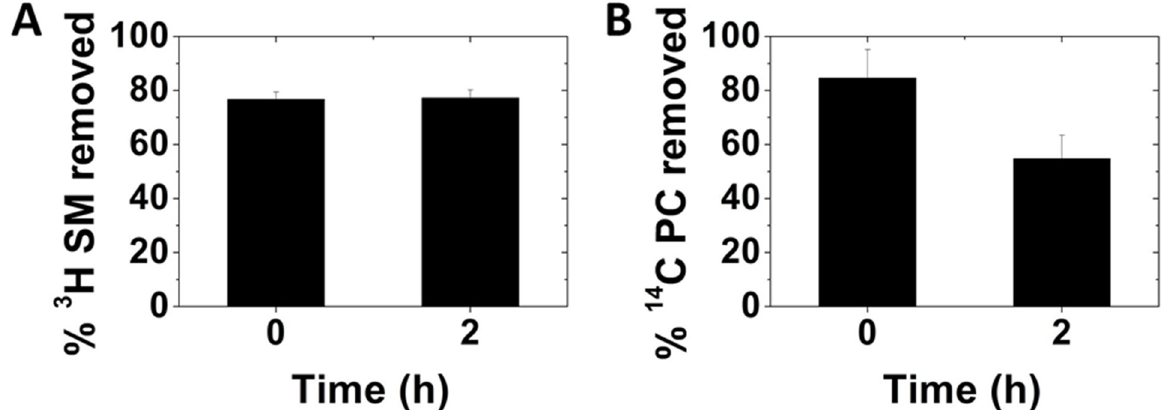
Fig 11. Analysis of back exchangeability of radiolabeled SM or POPC introduced into A549 cells by lipid exchange. (A) Back exchangeability of 3 H-SM immediately after exchange (0) or 2 h recovery after exchange with 1:1 bSM:POPC. (B) Back exchangeability of 14 C-DOPC immediately after exchange (0) or 2 h recovery after exchange with POPC. The p value for the significance of the difference at 0 and 2 h is 0.04. Back exchangeability is given by the % of radiolabeled lipid removed after a 1h second lipid exchange step in the presence of M α CD using unlabeled lipid. Exchange was carried out in 3.5 cm diameter plates with 1 ml of lipid plus 40 mM M α CD (See Methods for details). Recovery was carried out at 37˚C in the same plates with 1.5 ml of complete growth medium. Mean and standard deviations from three experiments are shown.